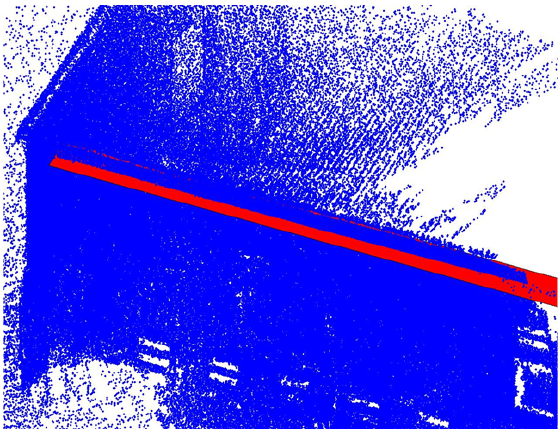
Figure 8: The rain gutter hypothesis (red) specified based on the underlying semantic 3D model and projected on the point cloud of the Frankenforst manor (blue).